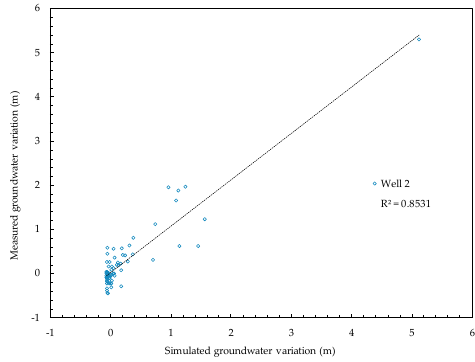
Figure 7. The model testing correlation relationship of Well 2.